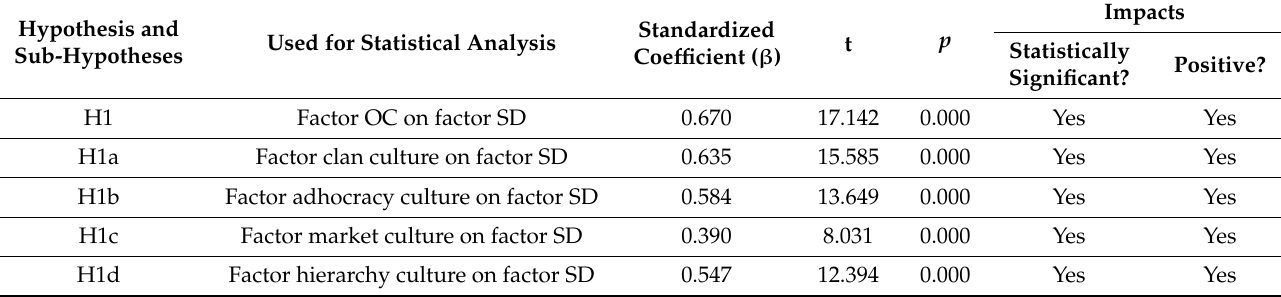
Table 2. Results of statistical analysis for hypothesis H1 and its sub-hypotheses.